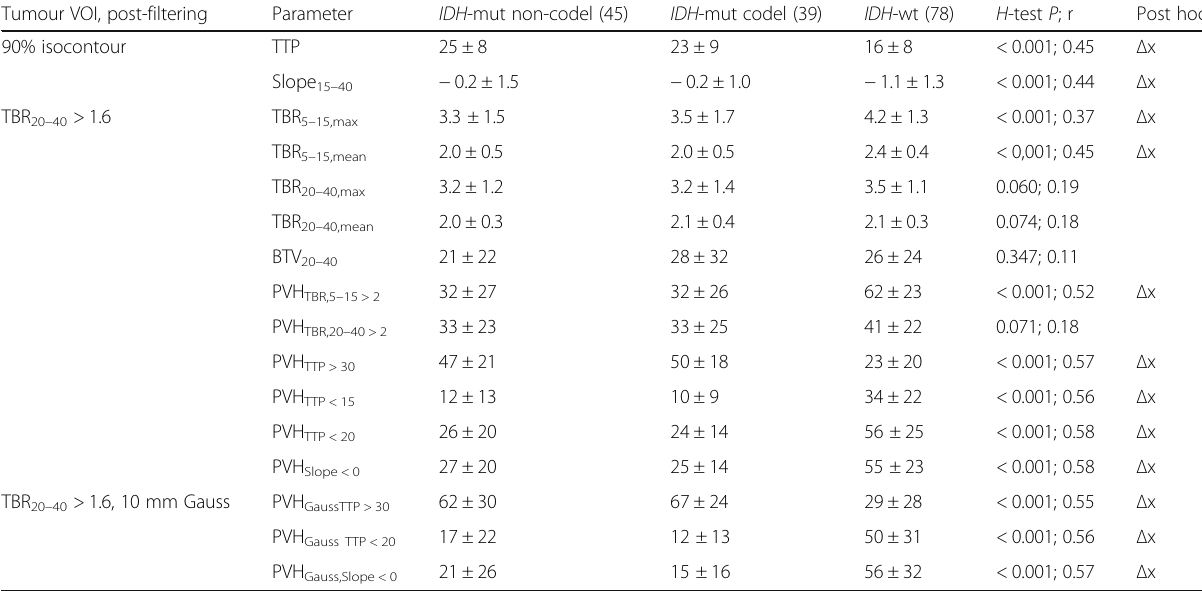
Table 3 Data shown as in Table 2, separated according to molecular genetic grading Tumour VOI,